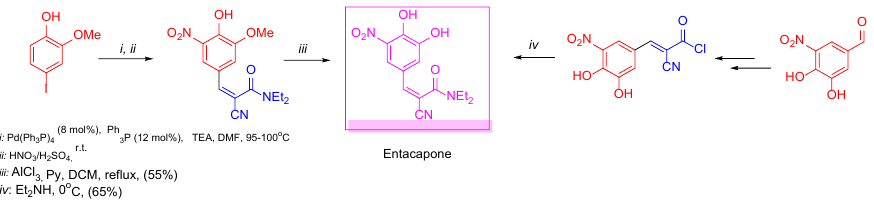
Scheme 5. Fu’s and Srikanth’s methods for the synthesis of